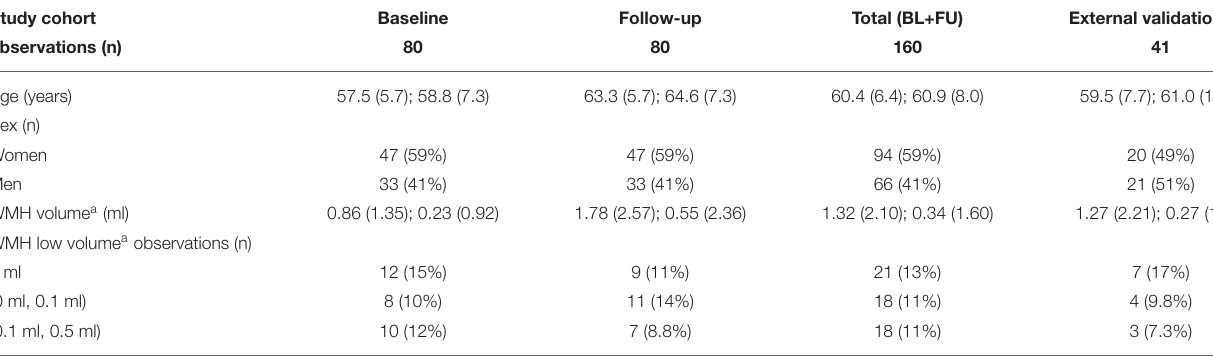
TABLE 3 | Descriptive statistics of the study cohort used for resampling and of the external validation set. Study cohort